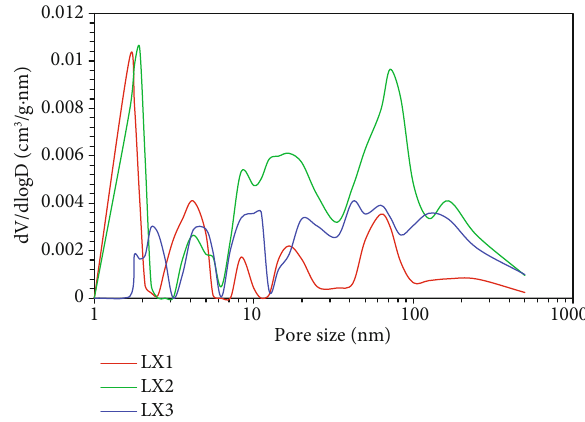
Figure 8: Pore size distributions of the three samples by